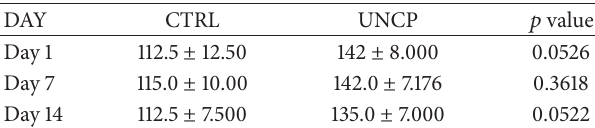
Table 3: Changes of body weight of adult male SD rats treated with 2000 mg/kg body weight of solution of UNCP.